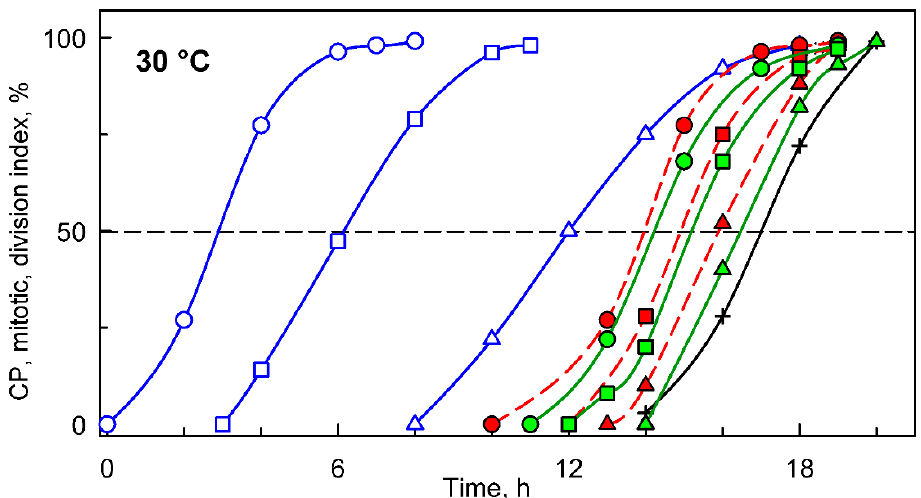
Figure 2. Graphical representation of the cell cycle progression in synchronized cultures of the Chlamydomonas reinhardtii grown at 30 °C at an incident light intensity of 500 µmol m − 2 s − 1 . Time courses of individual commitment point/s, nuclear division/s, protoplast fission/s, and daughter cell release in synchronized cultures of C. reinhardtii . Blue curves (CP indices): cumulative percentage of cells, in a given population (100%), that attained the commitment point (CP) for the first (circles), second (squares), and third (triangles) reproductive sequence. Red curves (mitotic indices): cumulative percentage of cells, in a given population (100%), that divided their nuclei into 2 (circles), 4 (squares), and 8 (triangles). Green curves (division / protoplast fission indices): cumulative percentage of cells, in a given population (100%), that divided their protoplasts into 2 (circles), 4 (squares), and 8 (triangles). Black curve, crosses: cumulative percentage of cells that released daughter cells. Black dashed line at 50% depicts midpoint of each event in a population of cells.